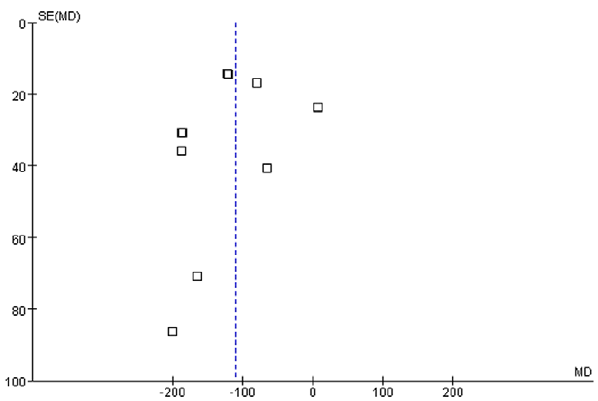
Figure 6. Herbal medicine plus active drug versus active drug, funnel plot for mean dose of levodopa